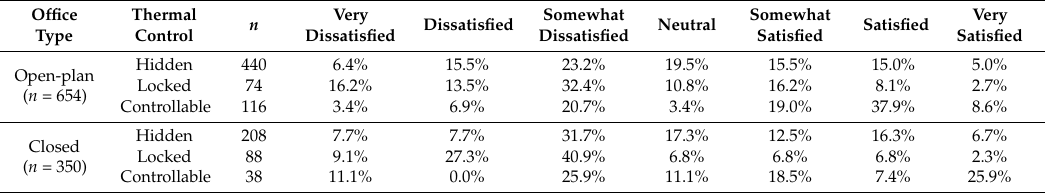
Table 12. Descriptive statistics for user satisfaction on air temperature by the level of